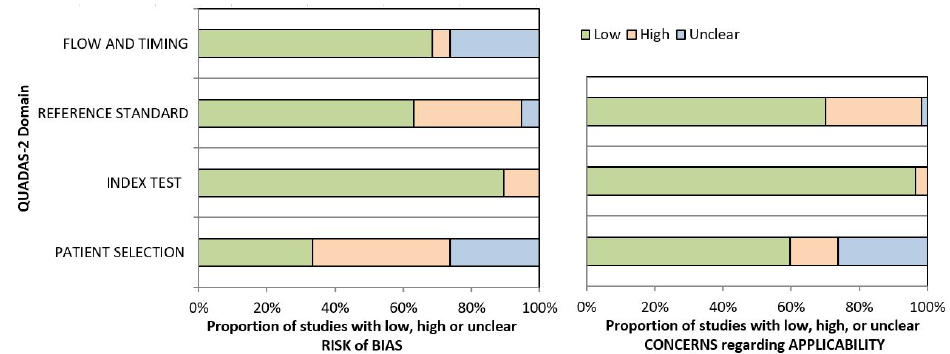
Figure 2. Summary of the methodological quality of included studies regarding the four domains assessing the risk of bias ( left ) and the three domains assessing applicability concerns ( right ) of the QUADAS-2 score. The portion of studies with a low risk of bias is highlighted in green, the portion with an unclear risk of bias is depicted in blue, and the portion with a high risk of bias is represented in